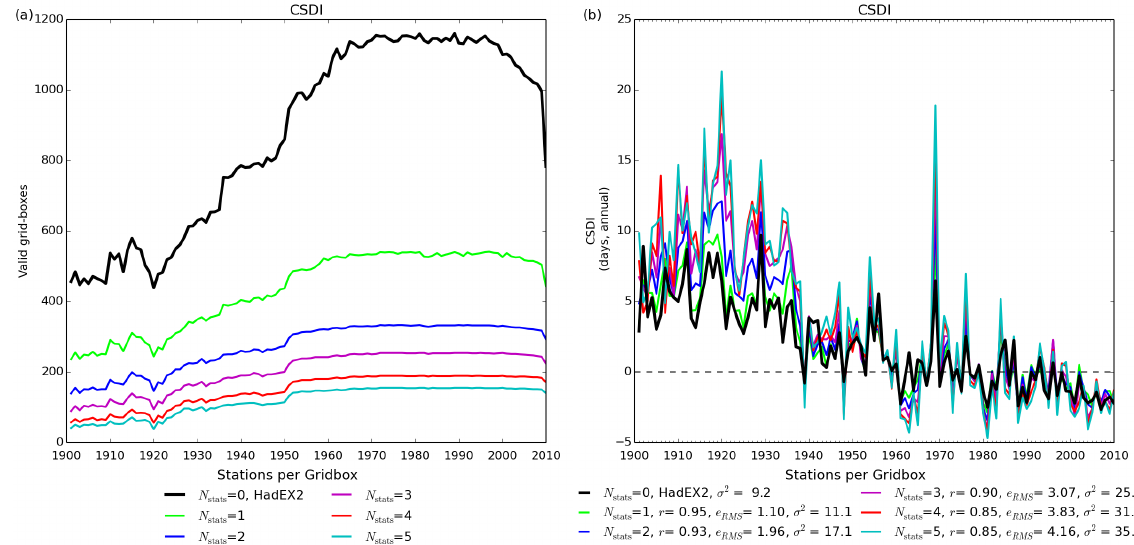
Figure 7. (a) The number of non-missing grid boxes and (b) the time series for global average CSDI (cold spell duration indicator) for the different numbers of stations within a grid box. Note that the global average only takes grid boxes which have 90% completeness or more, whereas all grid boxes are shown in the coverage series. All choices have been centered relative to the climatology period 1961-1990, reducing the spread during this time.